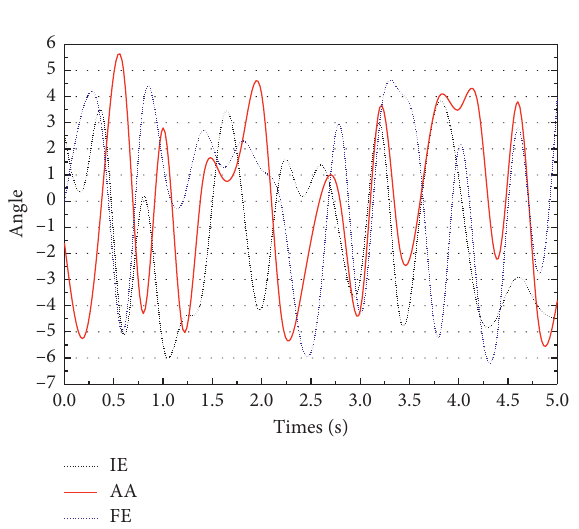
Figure 8: Articular motion of the knee joint of the right